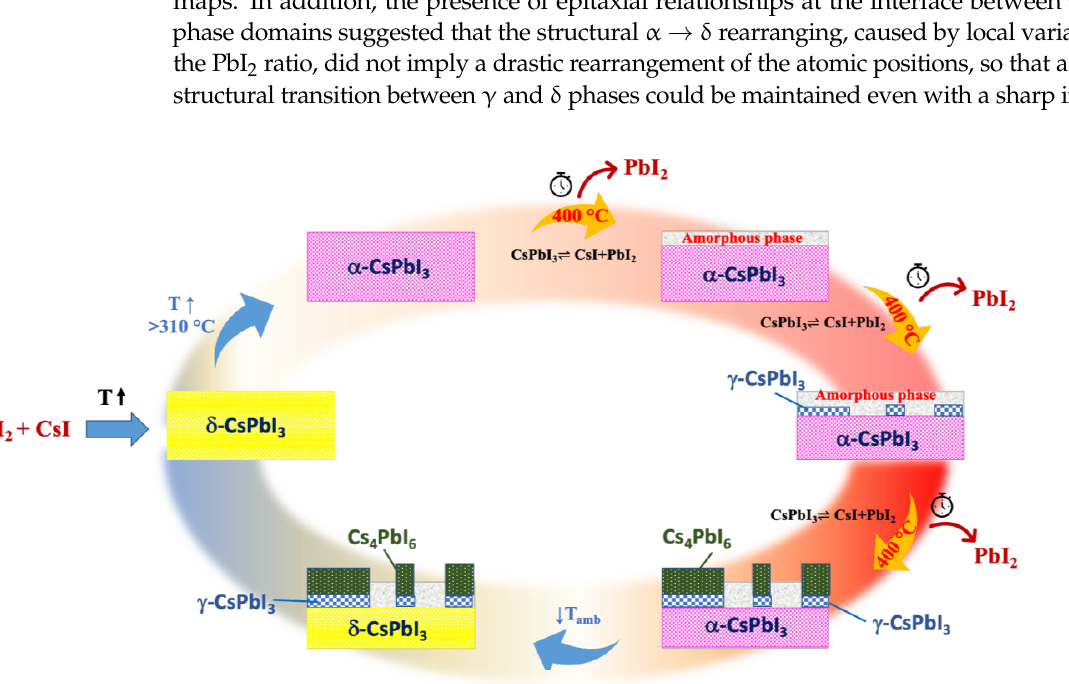
Figure 12. Model of the phase transition during the synthesis process and image of the sample after synthesis.